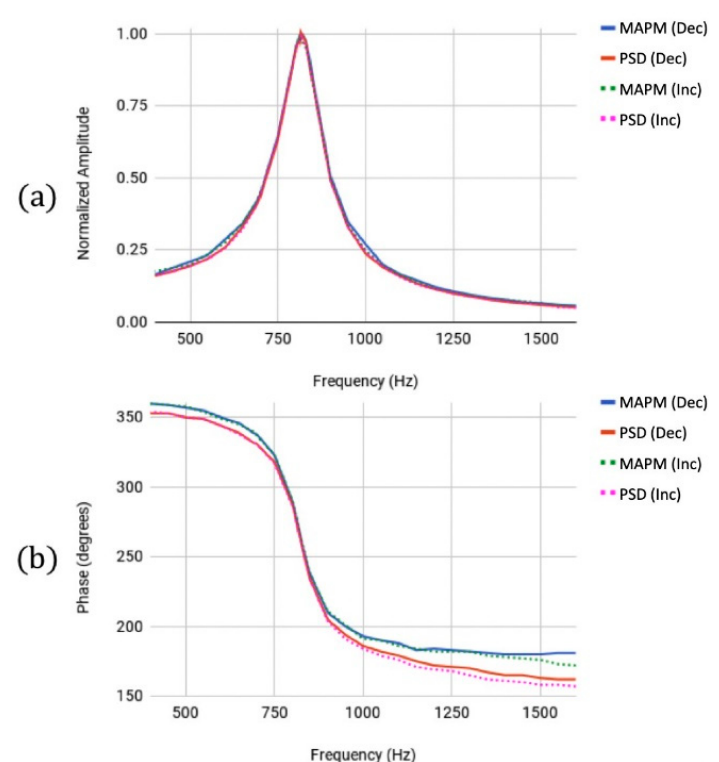
Figure 2. ( a ) Normalized amplitude responses measured by the MAPM (blue/green) and PSD (red/magenta) for low drive voltages. Both the decreasing amplitude frequency response (solid lines) and the increasing amplitude frequency response (dashed lines) have a maximum peak at 817.0 Hz with a Q of 7.8 for both sensors. ( b ) Phase responses measured by the MAPM (blue/green) and PSD (red/magenta). Both the decreasing (solid lines) and the increasing phase frequency response (dashed lines) show a steep phase gradient at 817.0 Hz.